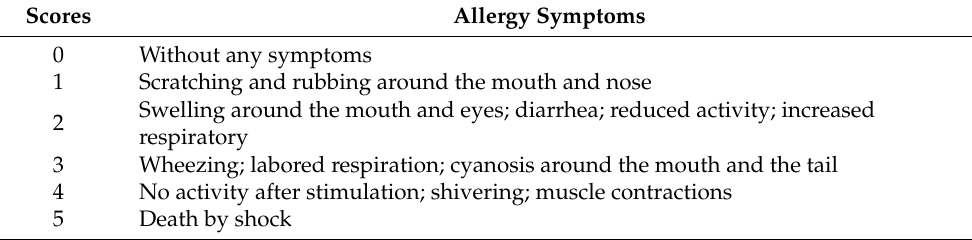
Figure 1. Procedure of animal experiments on mice and the effects of rosmarinic acid on the allergy symptoms. ( A ) Procedure for the mice food allergy model. Groups of mice (eight mice per group) were sensitized twice by intraperitoneal injection of OVA (5 mg/kg body weight) on days 0 and 14. From days 28 to 40, the mice were intragastrically administered with OVA (2.5 g · kg − 1 body weight) five times. Meanwhile, mice in the RA intervention group were orally challenged with RA (30, 90, and 270 g · kg − 1 body weight) once every day from days 27 to 40. One hour after the last challenge, anaphylaxis symptoms and related anaphylaxis serum indicators were evaluated. ( B ) Score of anaphylactic symptoms at 1 h after the last challenge. ( C ) Diarrhea rates at 1 h after the last challenge. ( D ) Rectal temperature differences at 45 min after the last challenge. ### p < 0.01, compared with the control group; *** p < 0.01 compared with the OVA-allergic model group. Table 1. Allergy